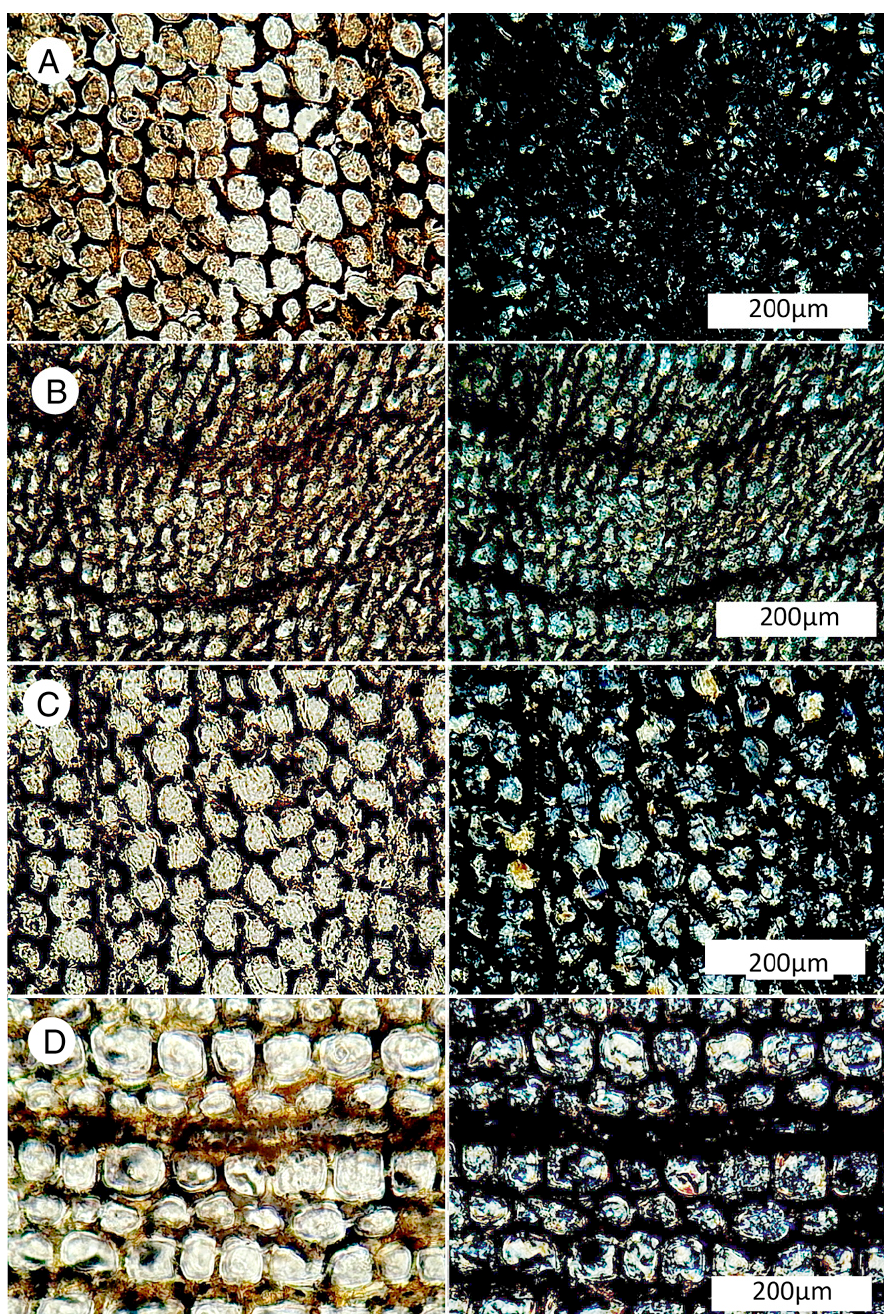
Figure 8. SEM images of Salitre specimen S1-A showing empty lumina. ( A ) Three adjacent tracheids with empty lumina; ( B ) The cell walls have been mineralized with microcrystalline quartz (arrow).